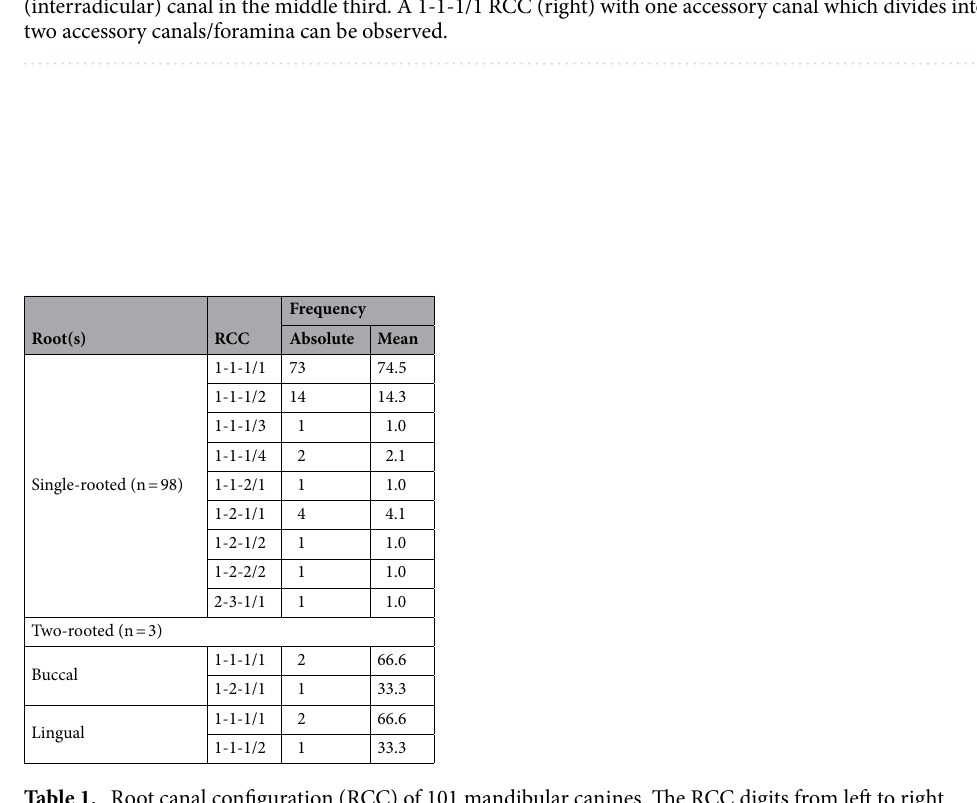
Table 1. Root canal configuration (RCC) of 101 mandibular canines. The RCC digits from left to right describe the root canal number from the coronal, middle to the apical third of the root. The fourth digit, separated with a slash (/), depicts the physiological foramina number (n/total = 101, n/single-rooted = 98, n/ two-rooted = 3).